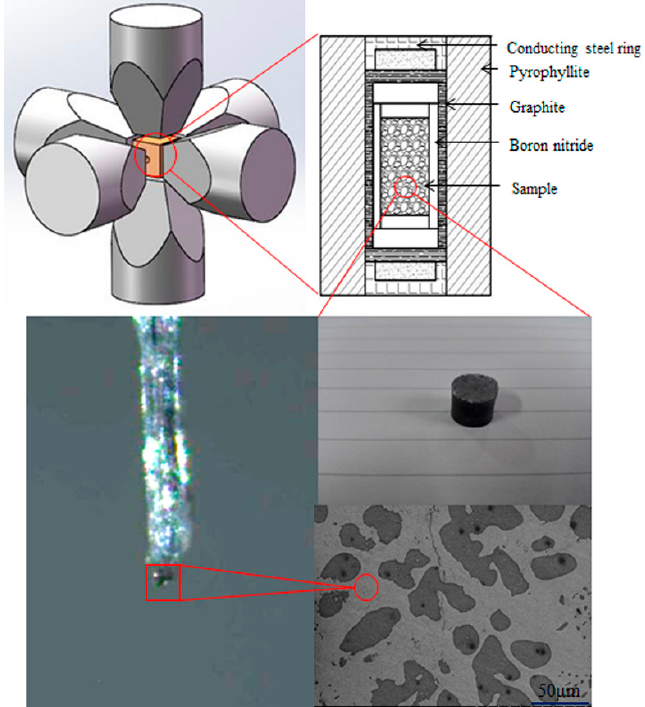
Figure 1. Schematic diagram of the high-pressure sintering (HPS) experiments with a six-anvil high-pressure apparatus. The zoomed-in figures are the layout of the crucible assembly, the cylindrical block of the sample and its scanning electron microscopy, the fragment of single crystal, respectively.